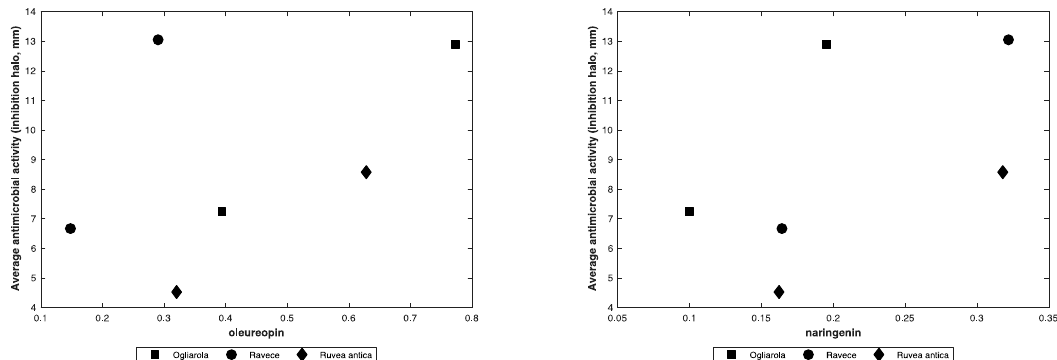
Figure 1. Average antibacterial activity exerted by the three PF extracts vs. oleuropein ( left ) and vs. naringenin ( right ). On X it is reported the amount (in µ g) of the molecules present in 2.5 and 4.9 µ g of the PF extracts tested.